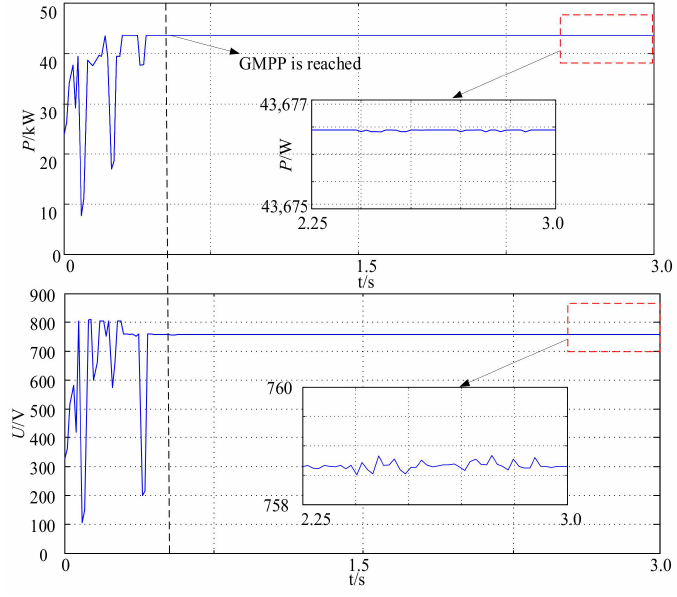
Figure 8. Voltage and power waveforms of IFA for case 2 if GMPP occurs at